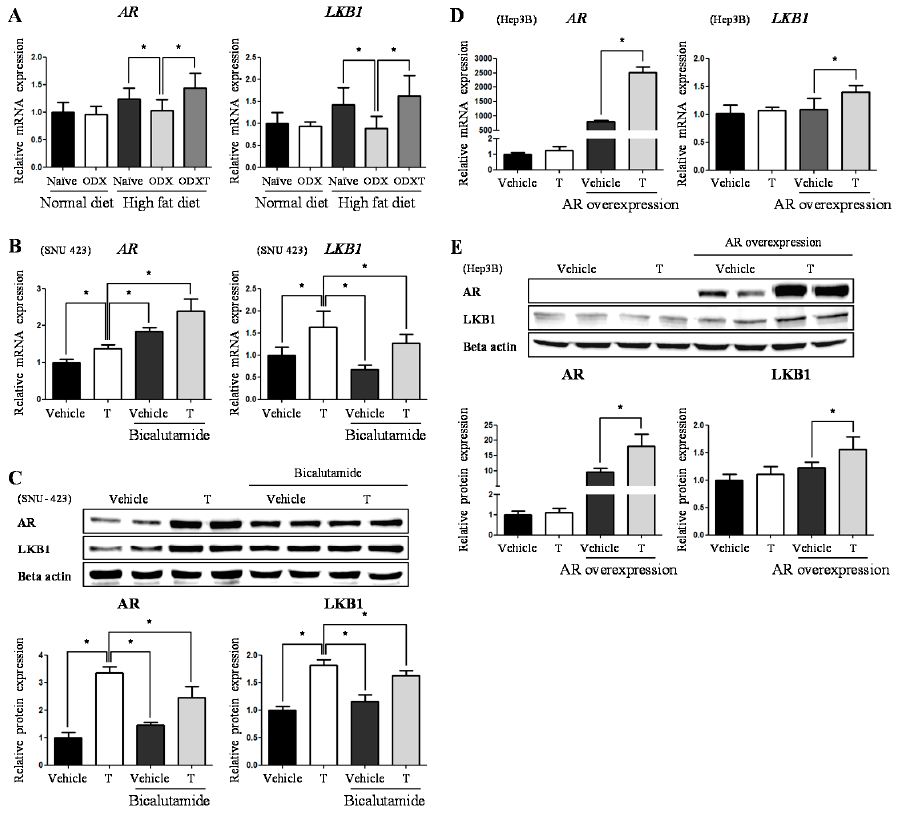
Figure 5. Testosterone increases the AR and LKB1 expression. Cell samples were treated with testosterone (T) (10 nM) with/without bicalutamide (5 µ M), incubated for 6 h after the treatment. ( A ) Using male mice liver, androgen receptor ( AR ) and LKB1 mRNA levels were determined by quantitative RT-PCR, using mRPLP0 as an internal control. ( B ) In vitro experiment using SNU-423 cells, AR and LKB1 mRNA level was determined by quantitative RT-PCR, using 18s as an internal control. ( C ) In vitro experiment using SNU-423 cells, AR and LKB1 proteins level is determined by Western blotting. Beta-actin (Rabbit) was used as an internal control. ( D ) In AR overexpression assay using Hep3B cells, AR and LKB1 mRNA level was determined by quantitative RT-PCR, using 18s as an internal control. ( E ) In AR overexpression assay using Hep3B cells, AR and LKB1 proteins level is determined by Western blotting. Beta-actin (Rabbit) was used as an internal control. The values stand for means +/ − S.D. * p < 0.05 was compared to groups indicated.